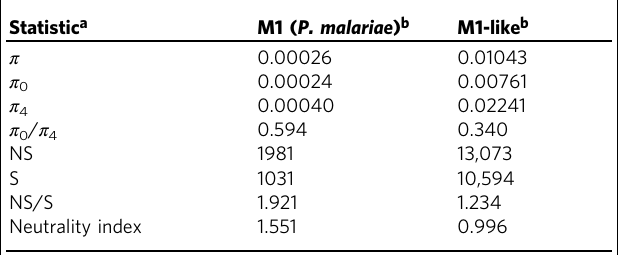
Table 2 Nucleotide diversity and polymorphisms in M1 and M1-like